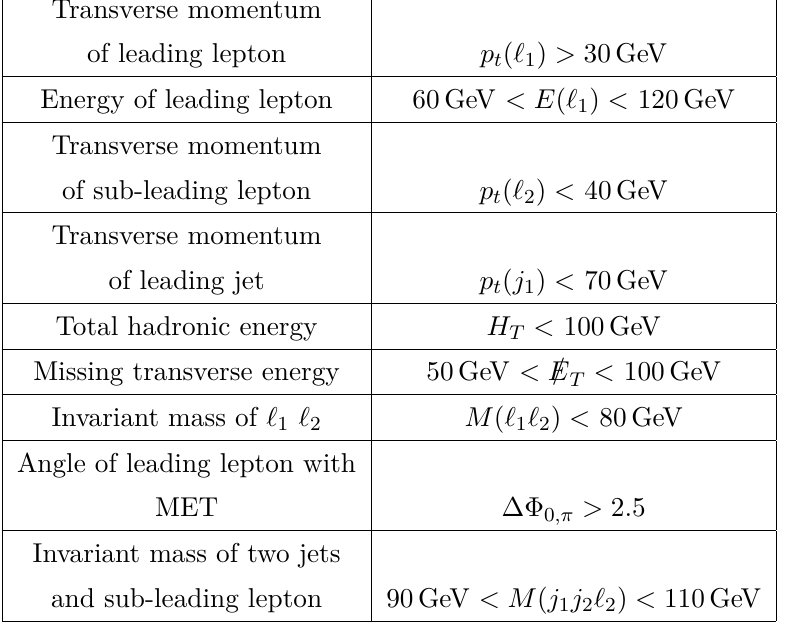
Table 3 . The full set of cuts used in out MC analysis.